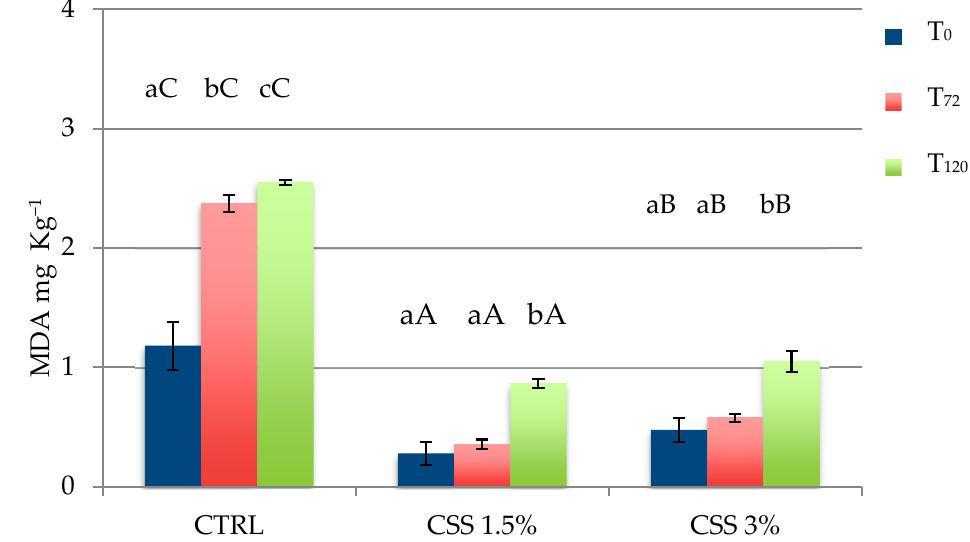
Figure 3. Results of Thiobarbituric acid reacting substances (TBARS) test, expressed as malon- dialdehyde (mg MDA kg − 1 ) in control (CTRL) and burgers formulated with CSS (1.5% and 3%, respectively), immediately after cooking (T 0 ) and after refrigerated storage (at 4 ◦ C, for 72 and 120 h, T 72 and T 120 respectively). Results are expressed as means ± standard deviations. Different lowercase letters indicate significant differences ( p < 0.05) among storage time of each batch; different uppercase letters indicate significant differences ( p < 0.05) among different batches, at same storage time. Table 4 . Qualitative profile of main volatile compounds (area %) in cooked samples (control, addition of coffee silver skin 1.5 and 3%), immediately after cooking process (T 0 ) and after 72 h of storage at +4 °C (T 72 ). VOCCs from Burgers’ Samples